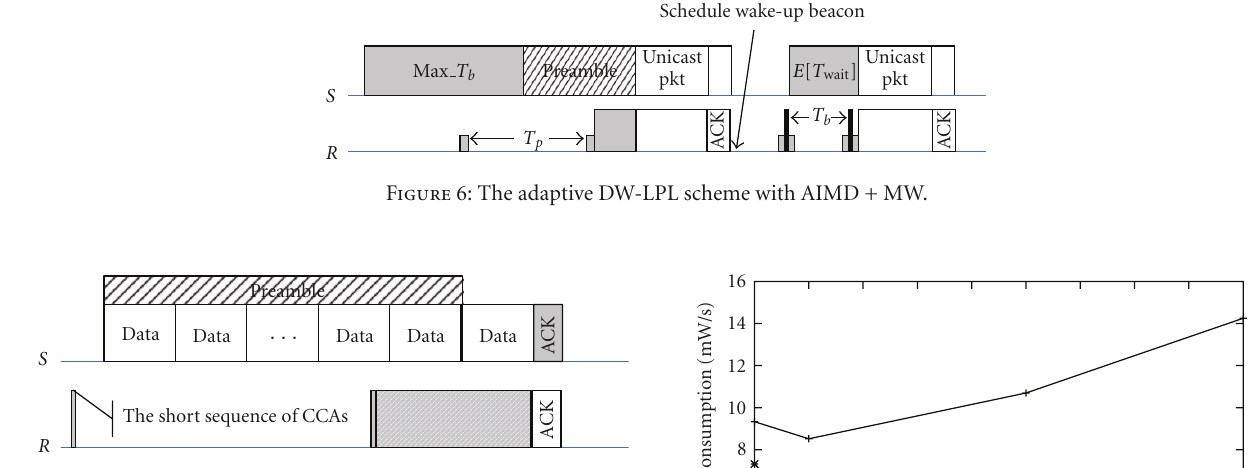
Figure 7: Experimental LPL method in TinyOS 2.x [17].